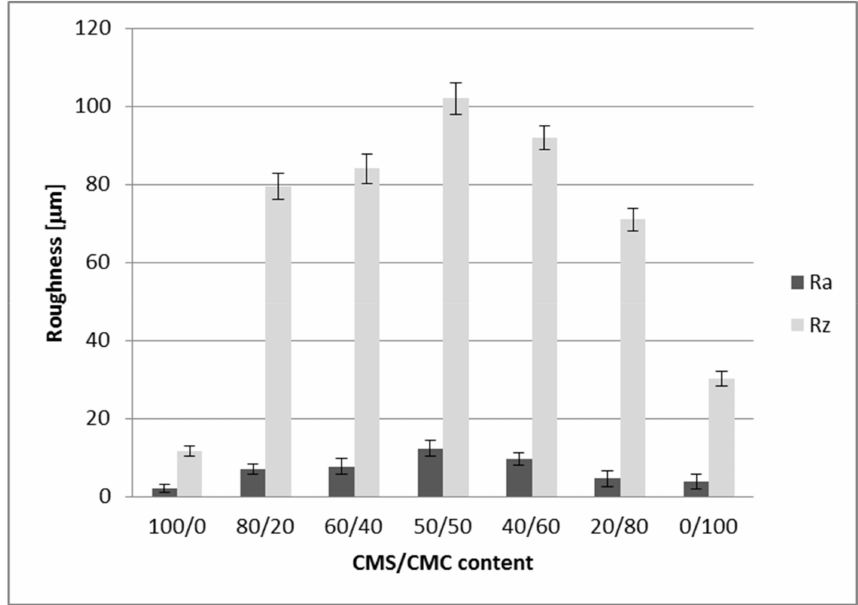
Figure 6. Roughness parameters R z and R a determined for CMS / CMC-based